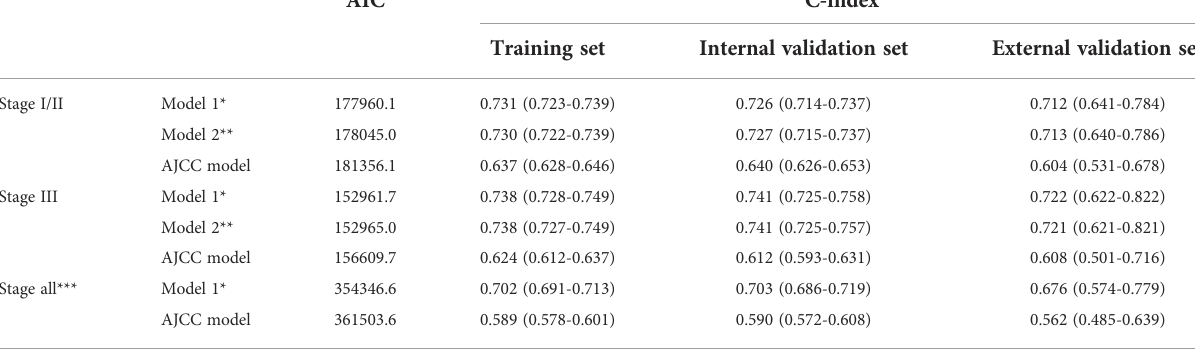
TABLE 2 AIC values of different models and C-indexes in predicting cancer-speci fi c survival in the training, internal validation and external validation data